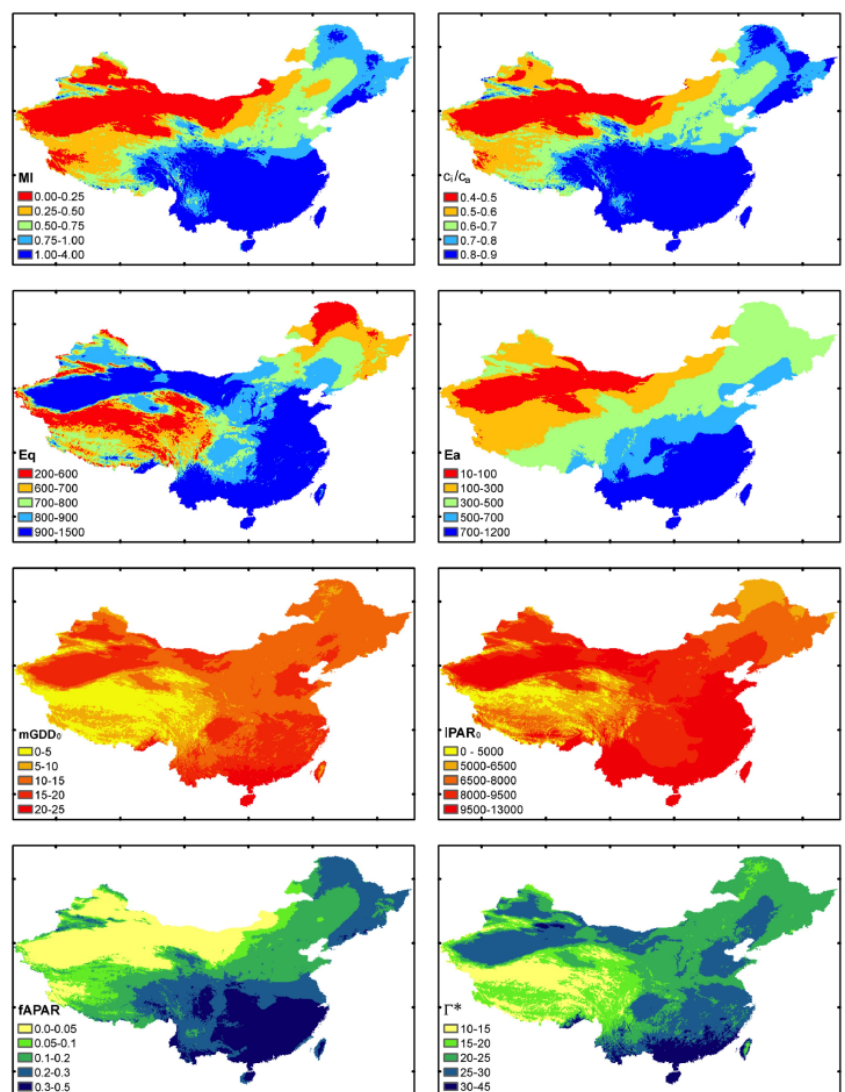
Fig. 1. The distribution pattern of eight environmental or ecophysiological variables: moisture index (MI), c i /c a ratio, equilibrium evapotran- spiration ( E q : mma − 1 ) , actual evapotranspiration ( E a : mma − 1 ) , mean temperature of the period above 0 ◦ C (mGDD 0 : ◦ C), accumulated photosynthetic active radiation during the period above 0 ◦ C (IPAR 0 : molm − 2 a − 1 ) , fraction of absorbed photosynthetic active radiation (fAPAR), CO 2 compensation point ( 0 ∗ :